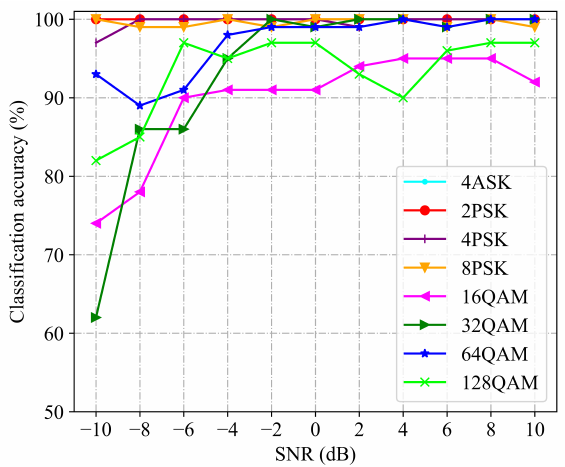
Figure 4. Accuracy comparisons of eight modulation types in different SNRs.